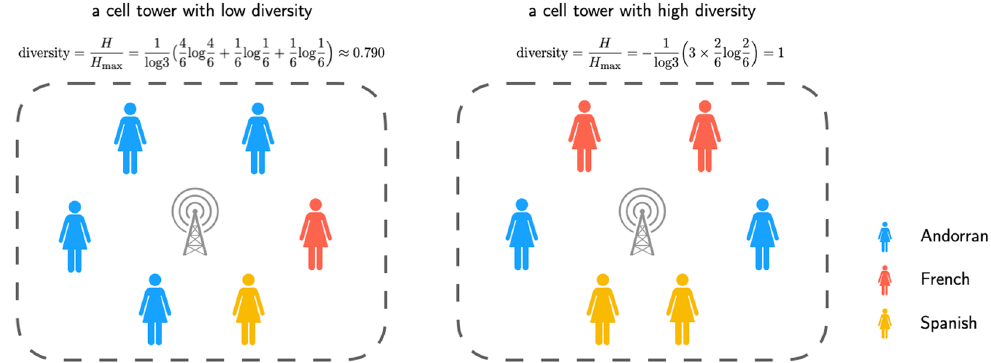
Fig. 1 Diversity at cell tower. We illustrate the diversity measure on nationality. Assume individuals connecting to the cell tower come from one of the countries, {Andorra, Spanish, French}. The left panel — dominated by Andorrans — is less diversi fi ed than the